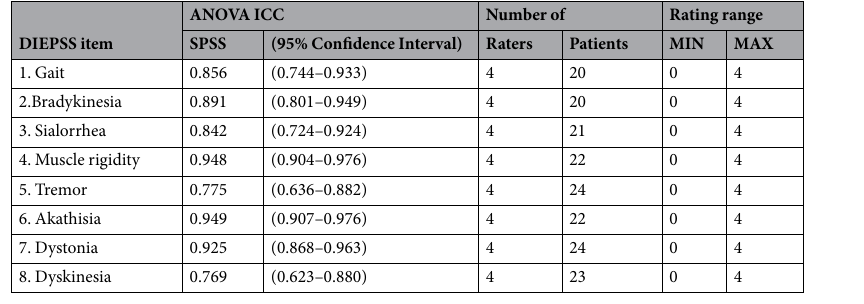
Table 1. Inter-rater reliability of DIEPSS Serbian version.